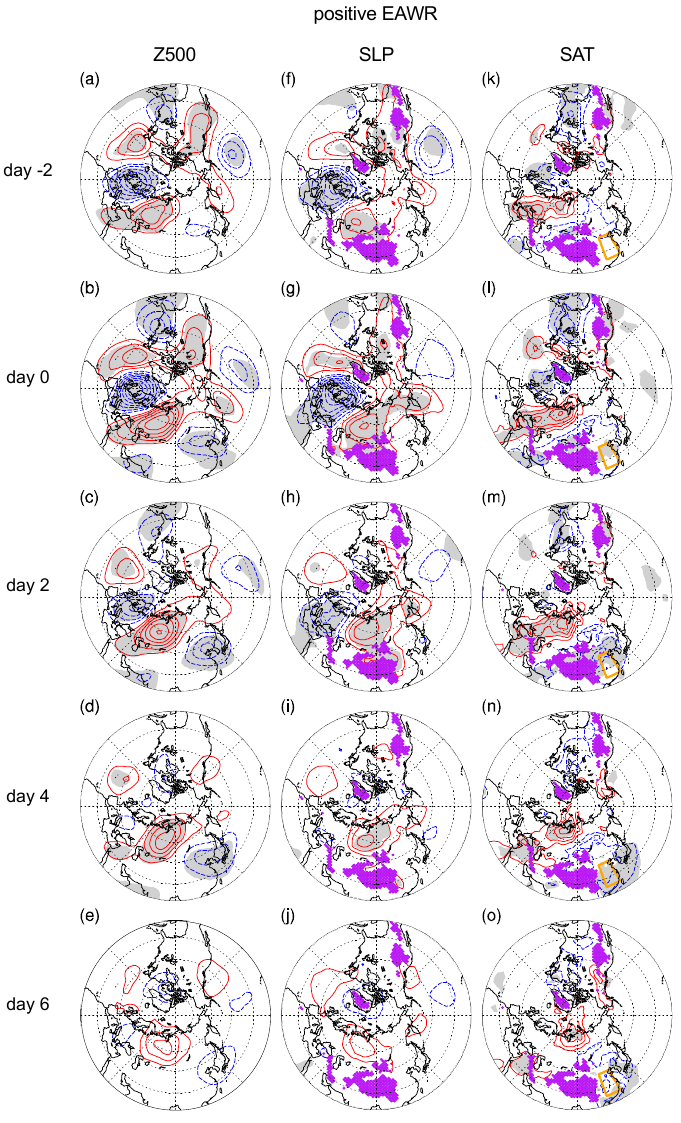
Figure 7. (a–o) Same as subfigures (a – o) of Figure 4, respectively, but for 64 positive EAWR events. Figure 7. ( a – o ) Same as subfigures ( a – o ) of Figure 4, respectively, but for 64 positive EAWR events. p are 0.005, 0.003, and 0.003 for the composites of Threshold values for the significance level * Threshold values for the significance level p ∗ are 0.005, 0.003, and 0.003 for the composites of FDR FDR anomalous Z500, SLP, and SAT, respectively. anomalous Z500, SLP, and SAT,